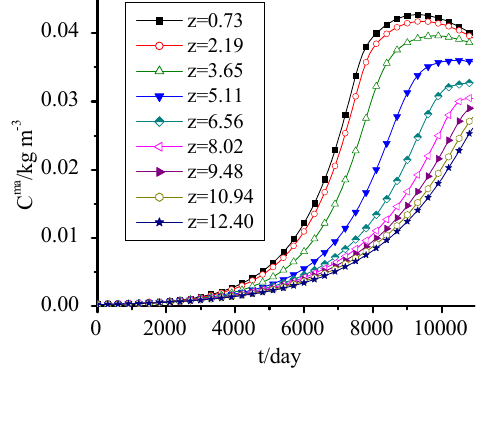
Figure 10. ANM concentration change with